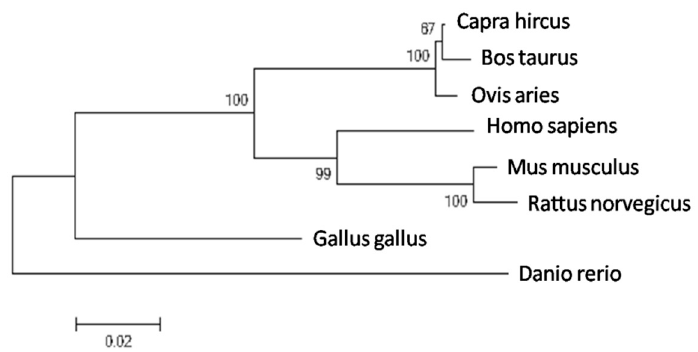
Figure 1. Phylogenetic tree of the PDE9A gene in different species. Numbers at each branch showed the percentage based on neighbor joining.